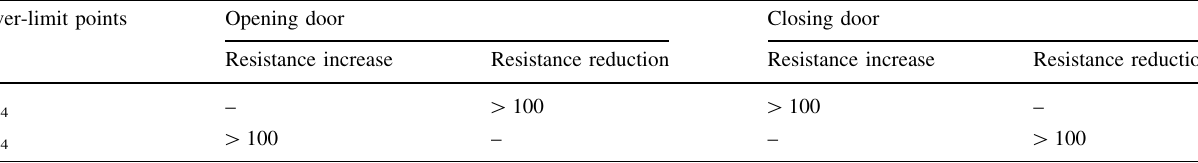
Table 5 Rules for serious resistance change in whole process Over-limit points